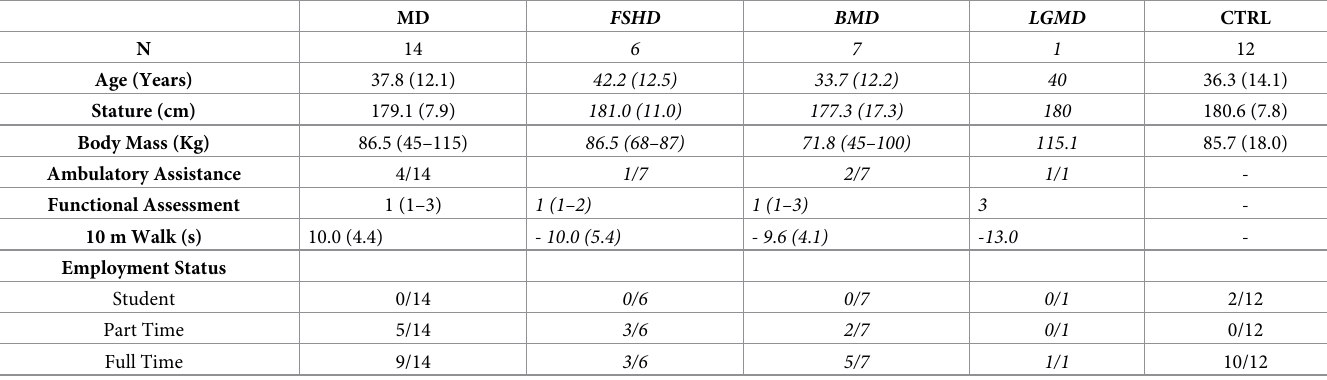
Table 1. Participant characteristics.